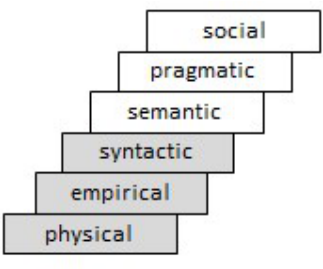
Fig. 12. Semiotic “ladder”, depicting levels in which signs’ presence and activity in an organization can be studied. Adapted from